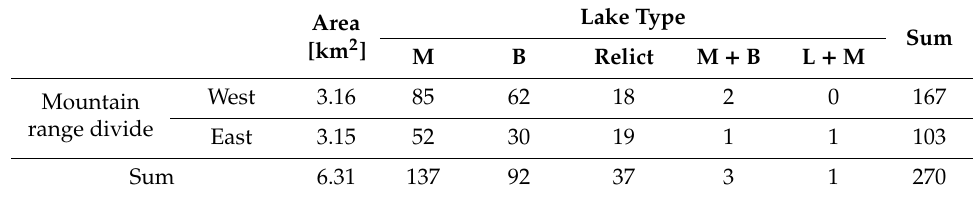
Table 2. Lake inventory-distribution of lake types on the east and west of the range divide.